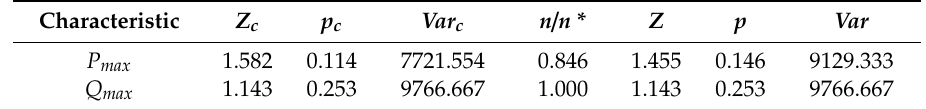
Table 1. The results of the significance analysis of the trend for the observation series P max and Q max in the Grajcarek